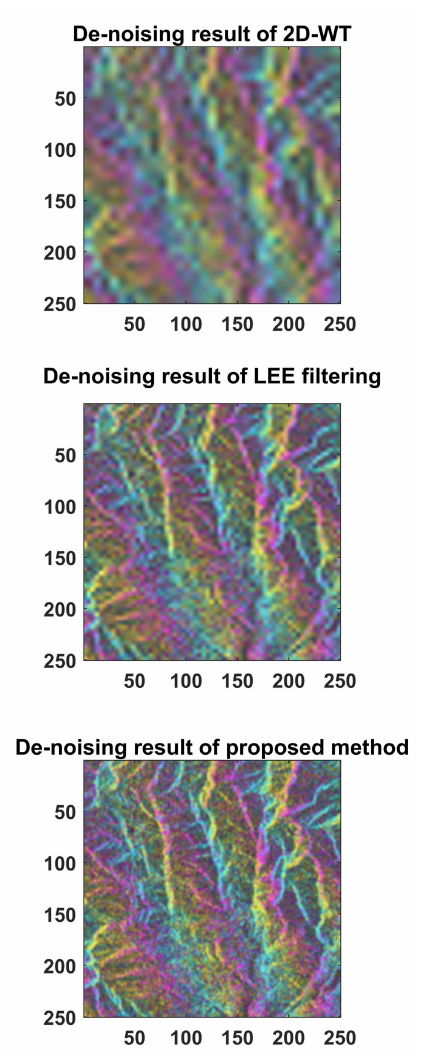
Figure 6. De-noising results acquired from various methods.